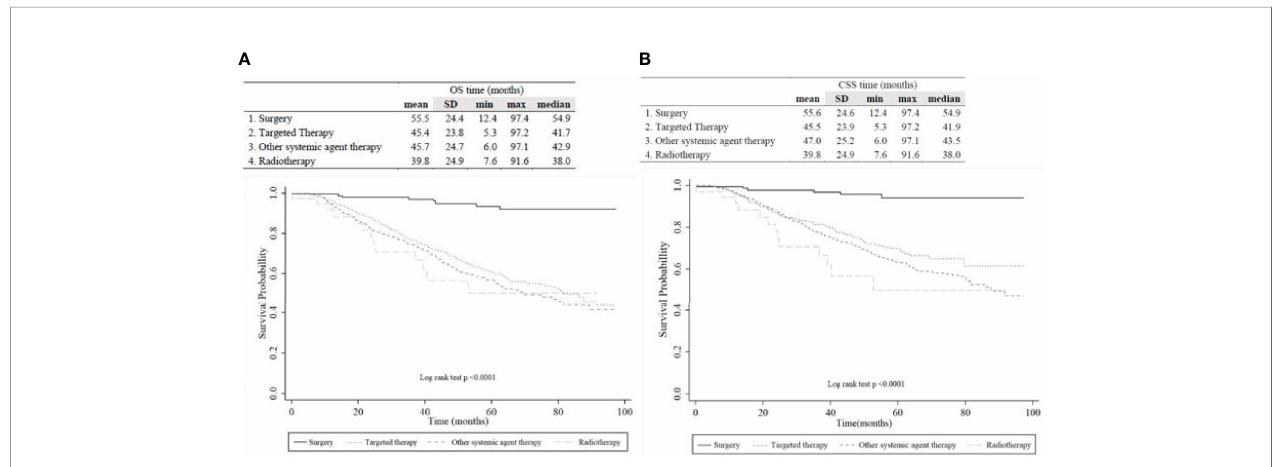
FIGURE 2 | Kaplan-Meier plot of (A) overall survival and (B) cancer-speci fi c survival among overall patients according to the therapeutic